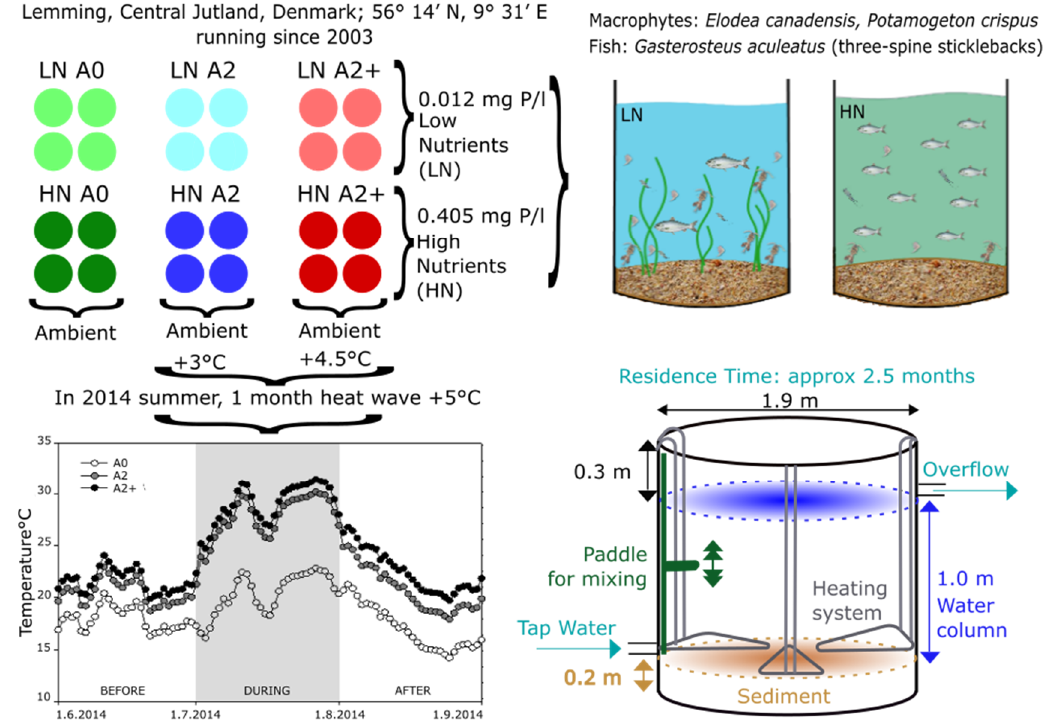
Figure 1. Graphical representation of methodology of the experiment.